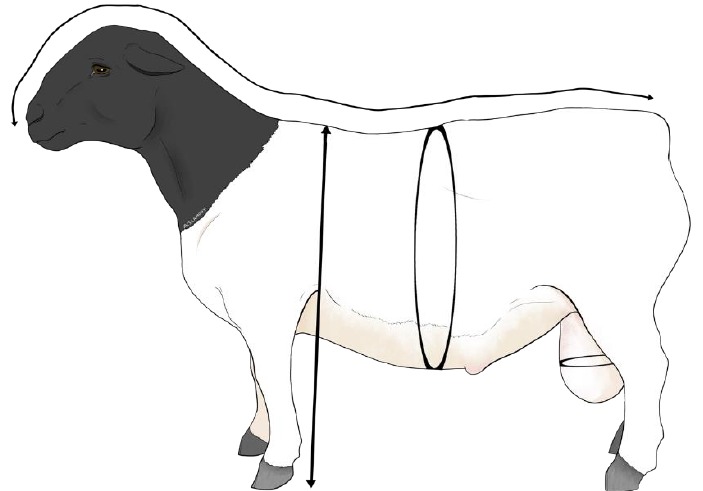
Figure 2. Morphological variables evaluated with a flexible plastic tape, and their body reference points: scrotal circumference (SCRC, cm), the tape was placed around the wider part of the scrotum; height at the withers (HEIG, cm), from the hoof to the withers; length (LENG, cm) from the snout to the base of the tail; and thoracic perimeter (PERI, cm), around the ribs, according to both low- and high-social-rank Dorper rams ( n = 24) in northern Mexico (25° N).